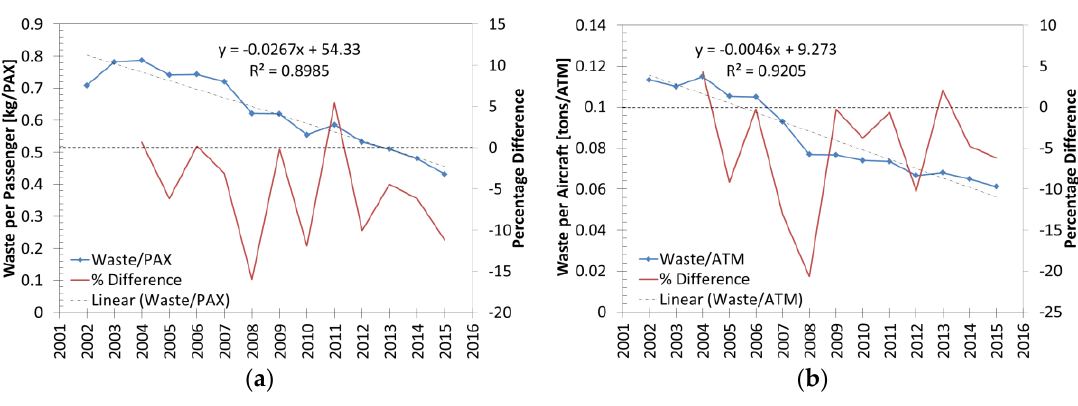
Figure 4. Total waste and year on year percentage difference at Kansai International Airport during 2002–2015: ( a ) per passenger; and ( b ) per aircraft movement. Source: Data derived from [60,66].